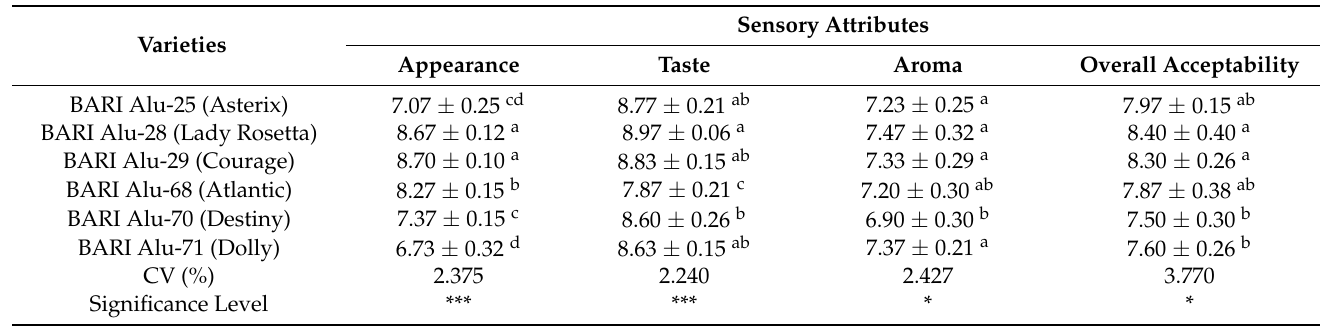
Table 5. Different sensory attributes (appearance, taste, aroma, overall acceptability) of potato chips.